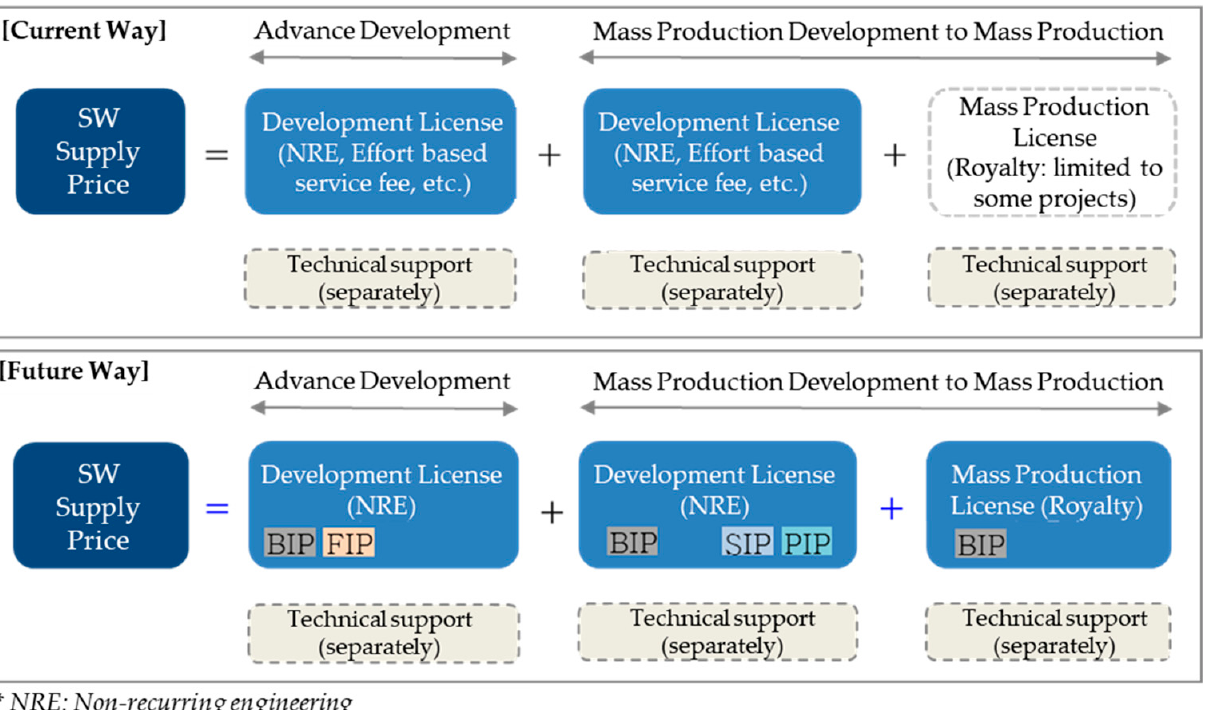
Figure 10. Source code similarity review method